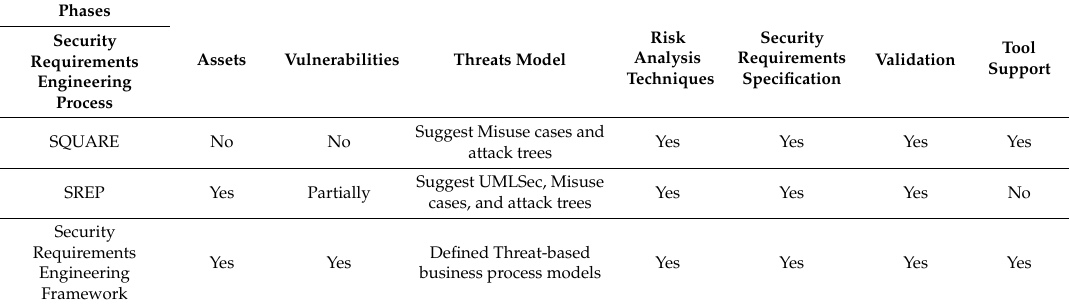
Table 6. Comparison of security requirements engineering process